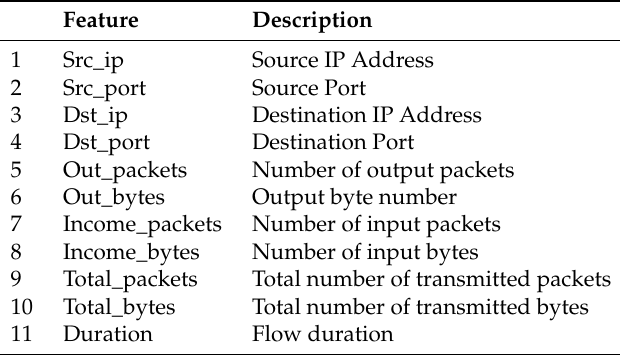
Table 3. Features examined in ISCX-Bot-2014 dataset.